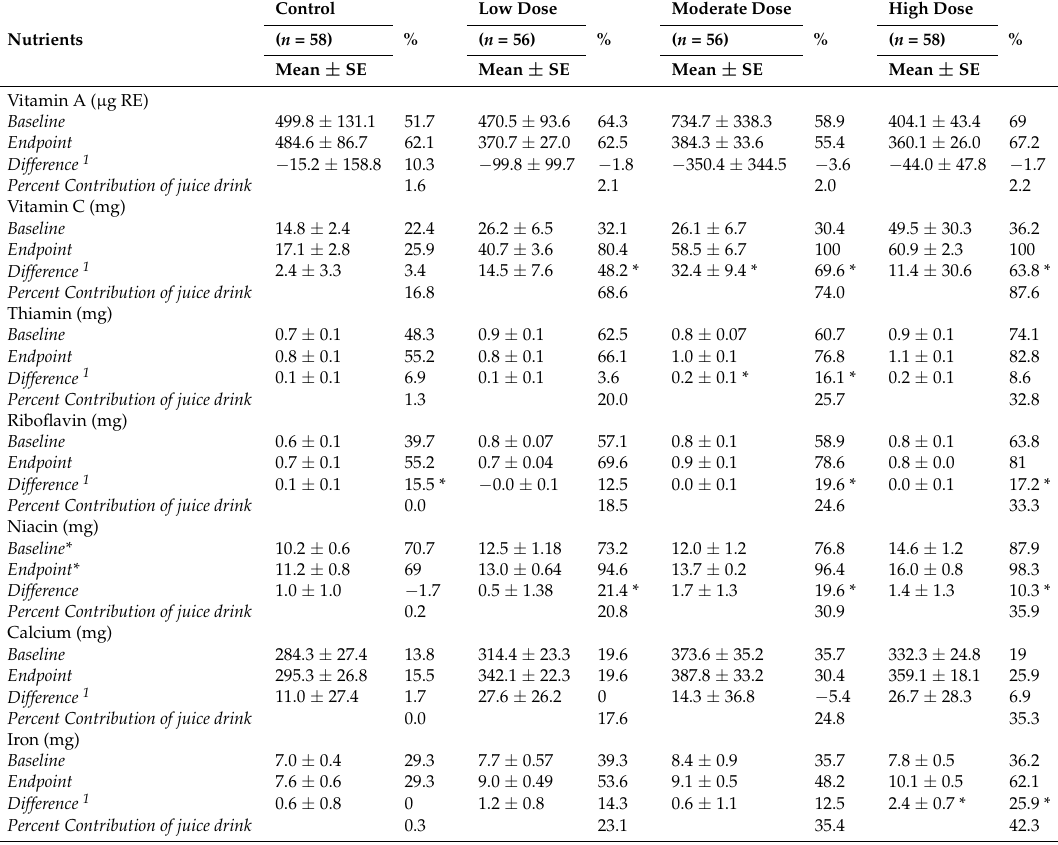
Table 5. Mean per capita nutrient intake of Children and Percentage meeting the EAR with fortified juice drink by group by period